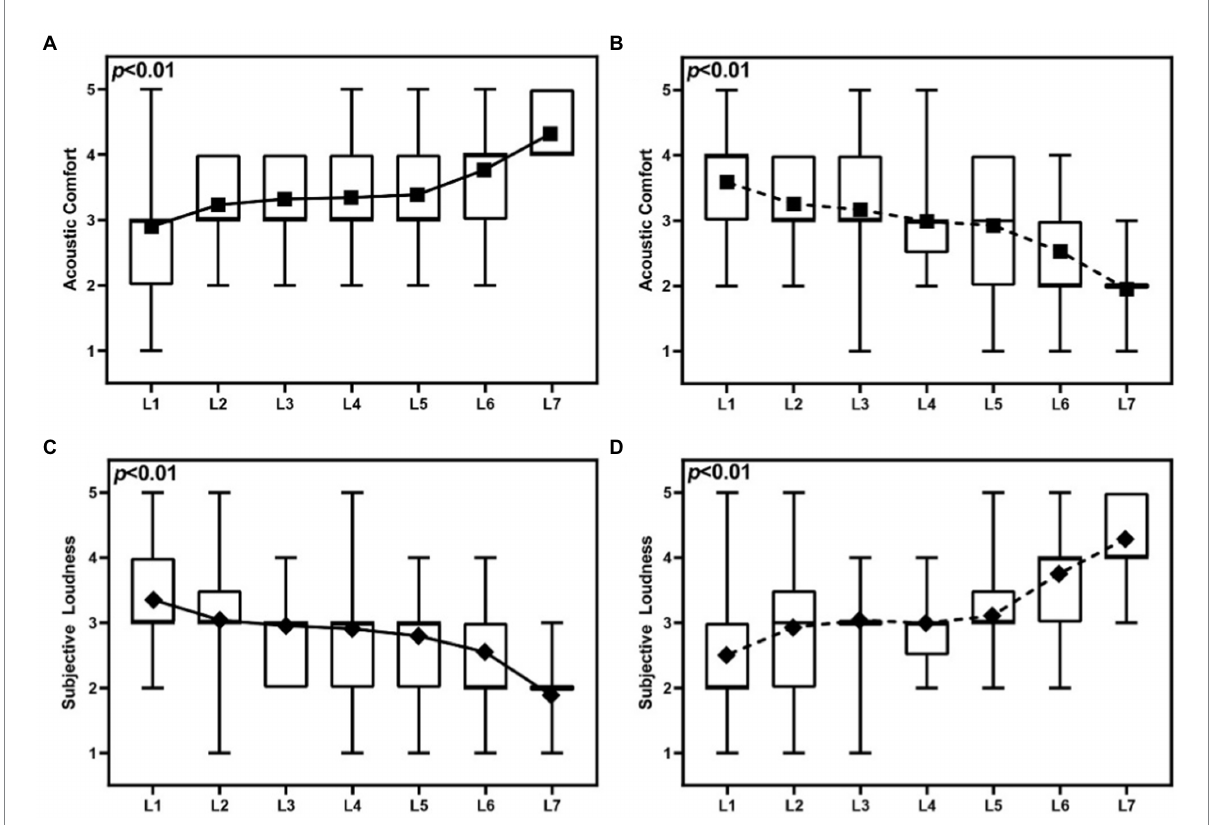
FIGURE 6 Results of different locations of peaks segments that affect acoustic comfort and subjective loudness in the soundwalk paths (A) Results of different locations of PPAS that affect acoustic comfort, (B) Results of different locations of NPAS that affect acoustic comfort, (C) Results of different locations of PPAS that affect subjective loudness, and (D) Results of different locations of NPAS that affect subjective loudness (L: The locations of assessment of soundscape segments appear in the soundwalk